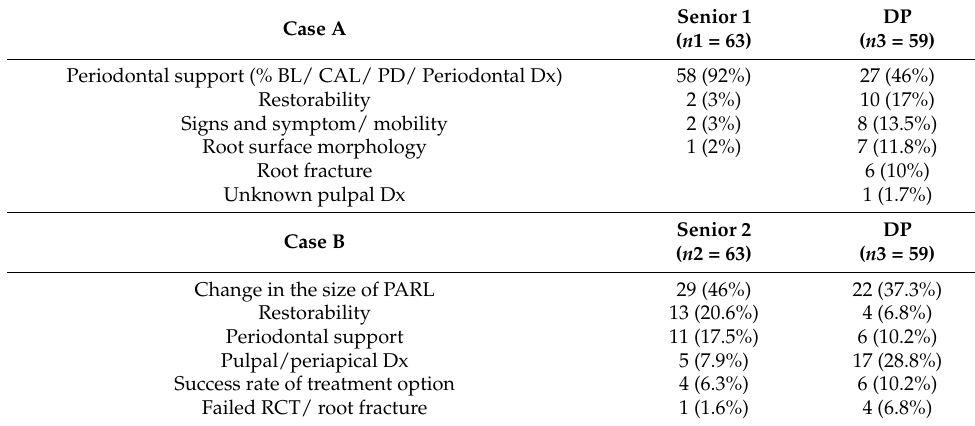
Table 4. Distribution of determinants for assigning a prognosis from the Senior 1, Senior 2, and Dental Practitioner (DP) groups. BL = bone loss, CAL = clinical attachment loss, PD = pocket